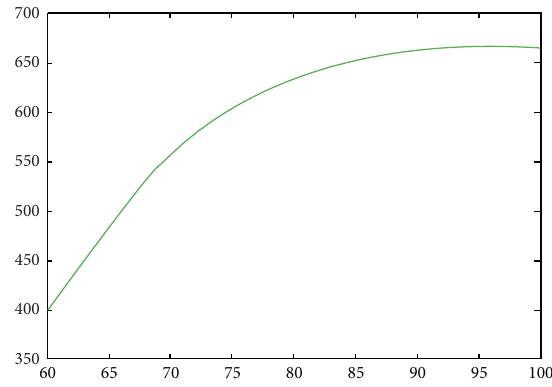
Figure 4: Emission of CO 2 with and without control.